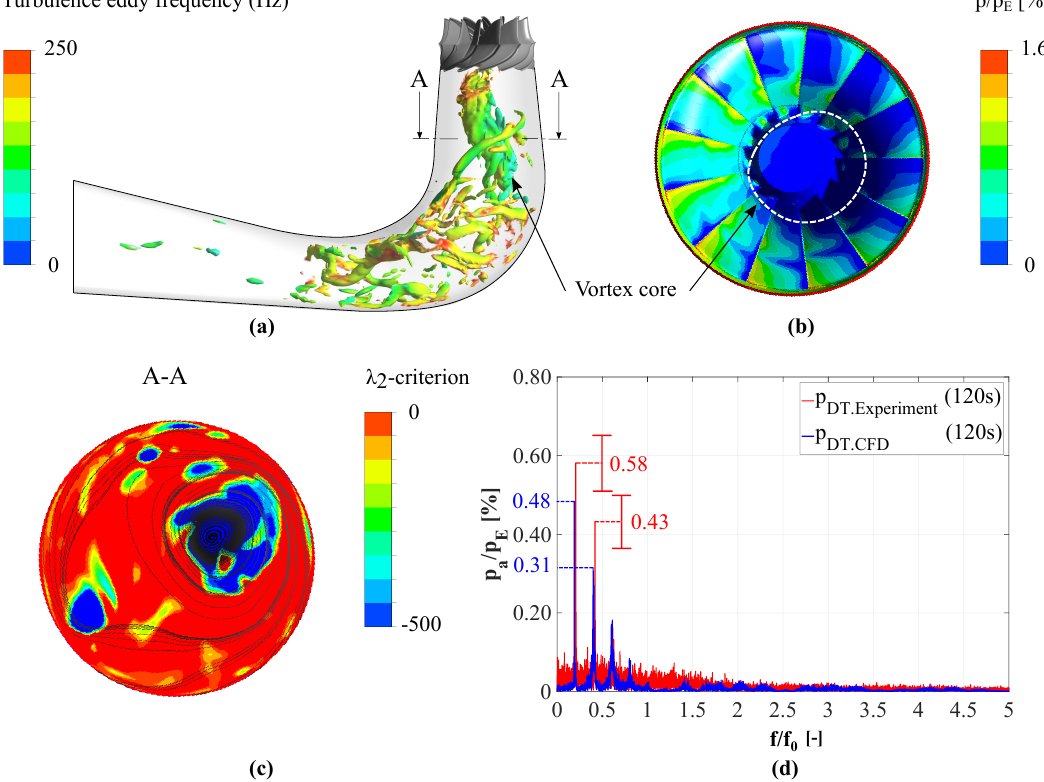
Figure 6. Draft tube vortex structure highlighted by ( a ) λ 2 -criterion including ( b ) the pressure distribution of the runner and ( c ) the λ 2 -criterion used at the 2D plane at section A-A as well as ( d ) a compartment of simulated and measured pressure fluctuations (44% · P RP